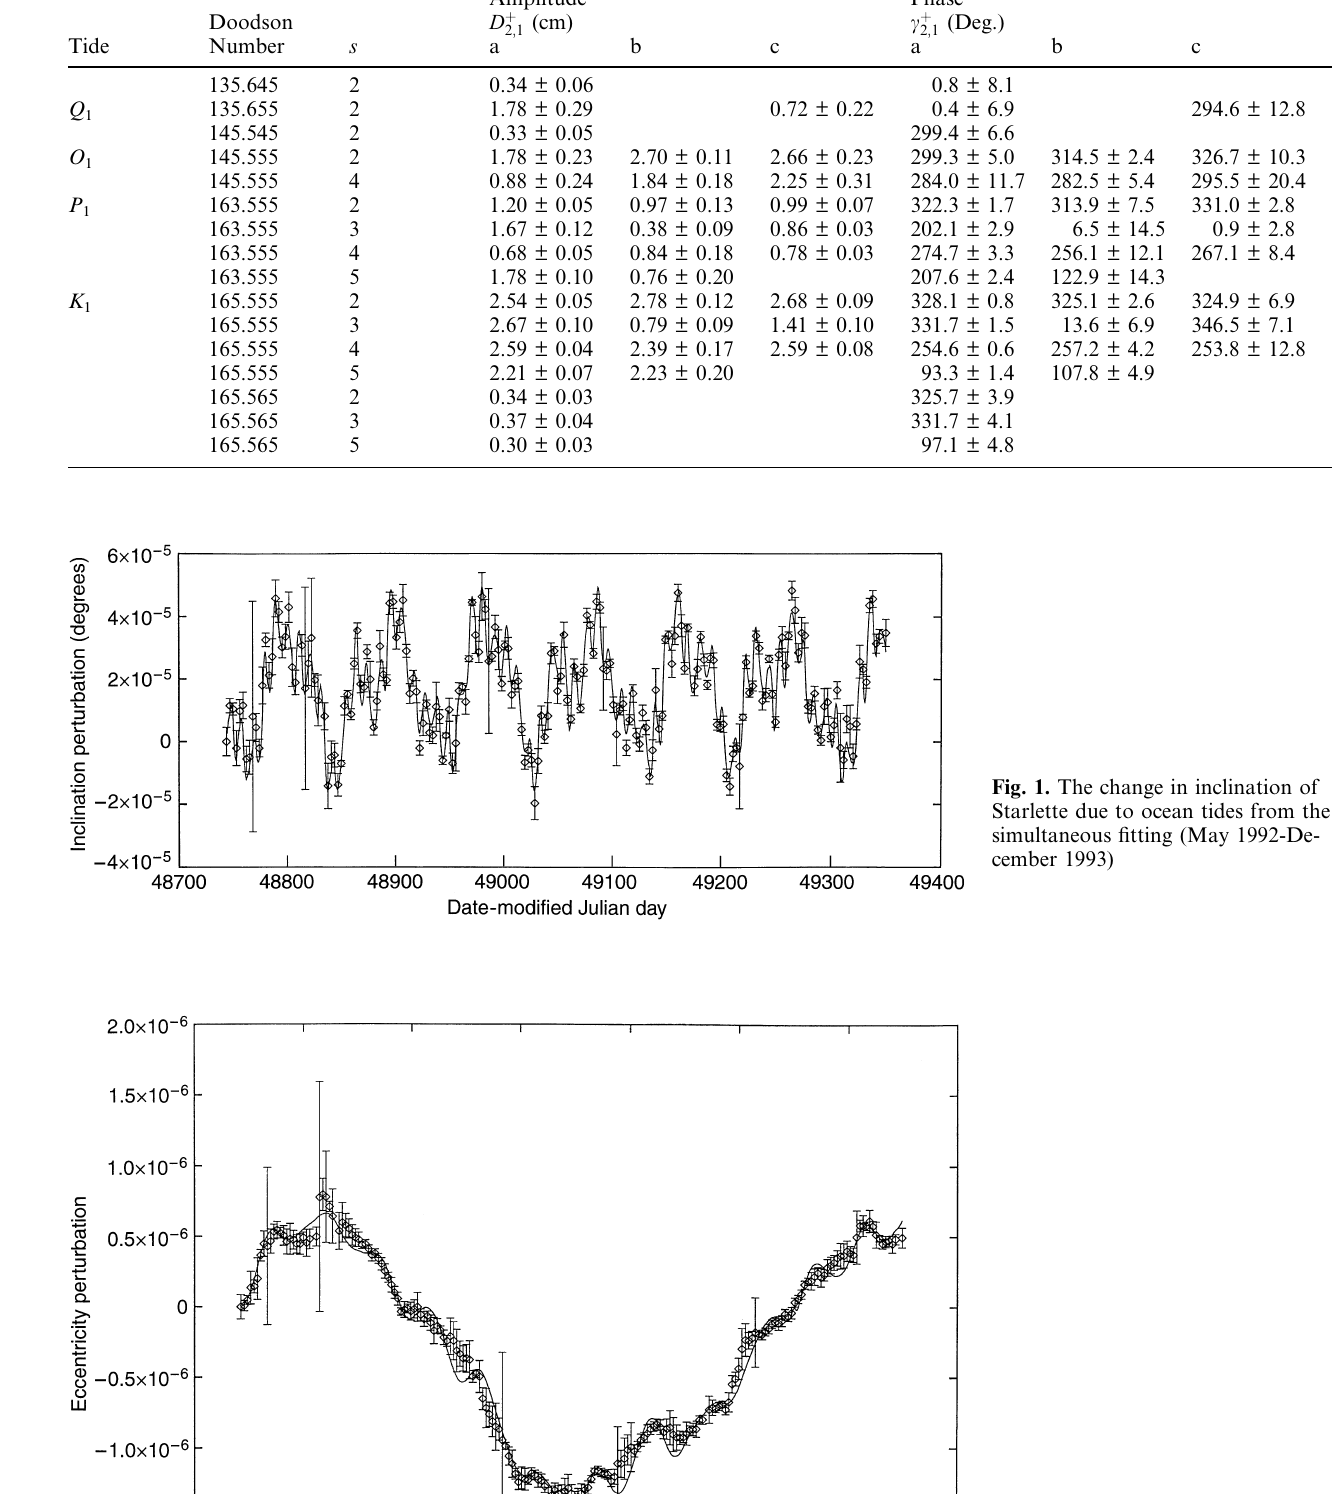
Fig. 2. The change in eccentricity of Starlette due to ocean tides from the simultaneous fitting (May 1992- December